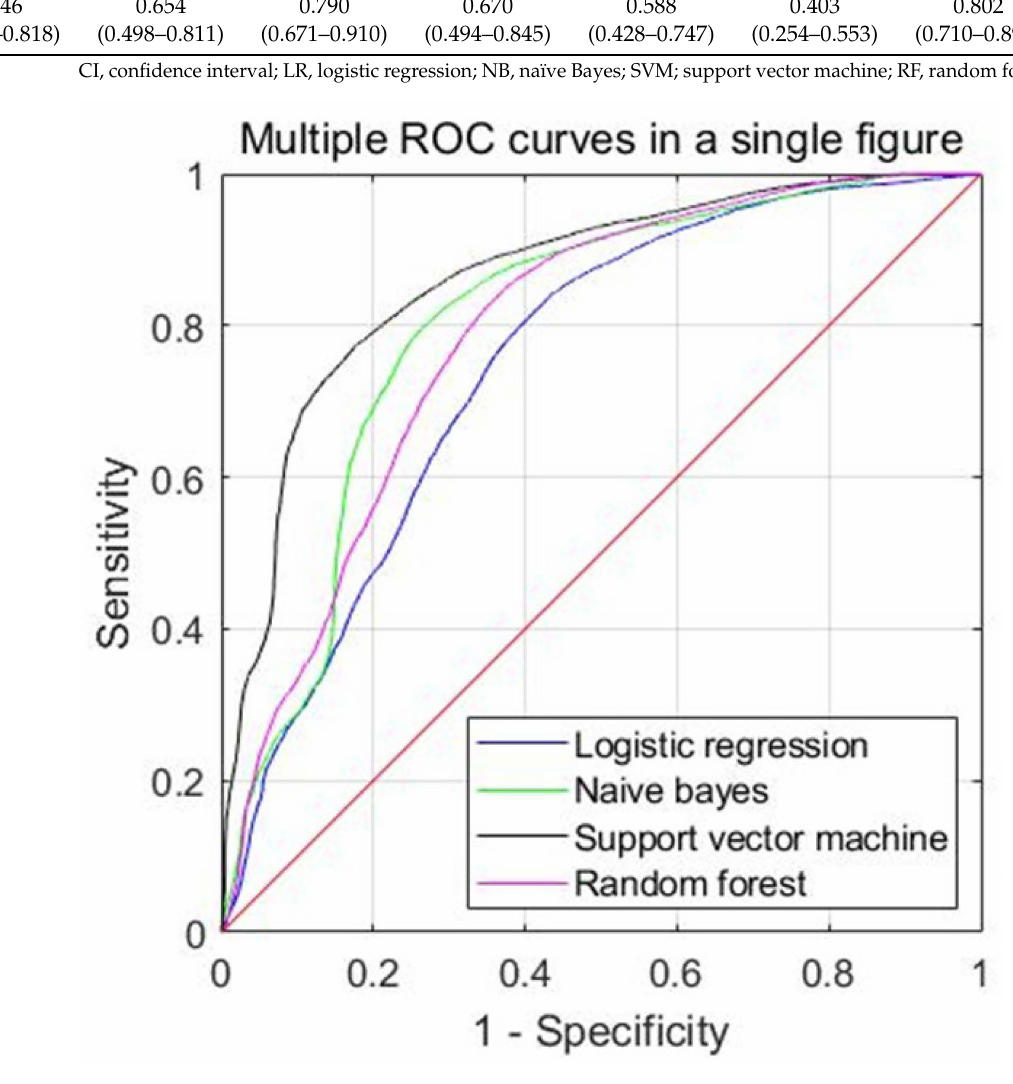
Figure 3. AUC value of each EEG based machine-learning prediction model for IICP in